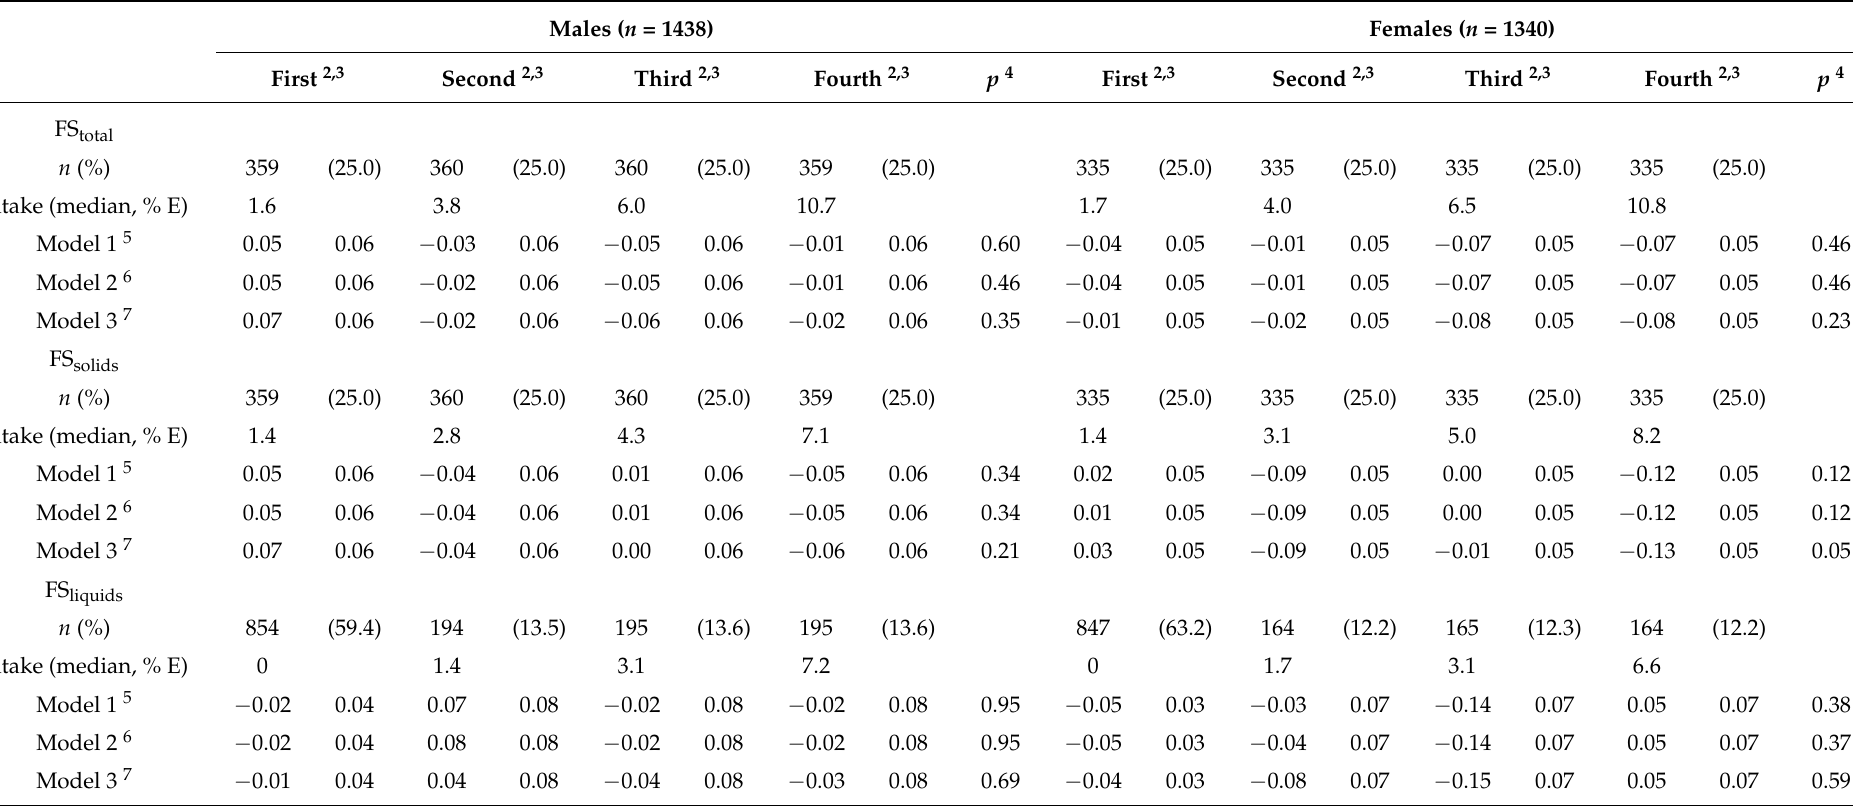
Table 3. BMI z-scores of Japanese children and adolescents aged 2–19 years according to free sugars intake: the 2016 National Health and Nutrition Survey, Japan 1